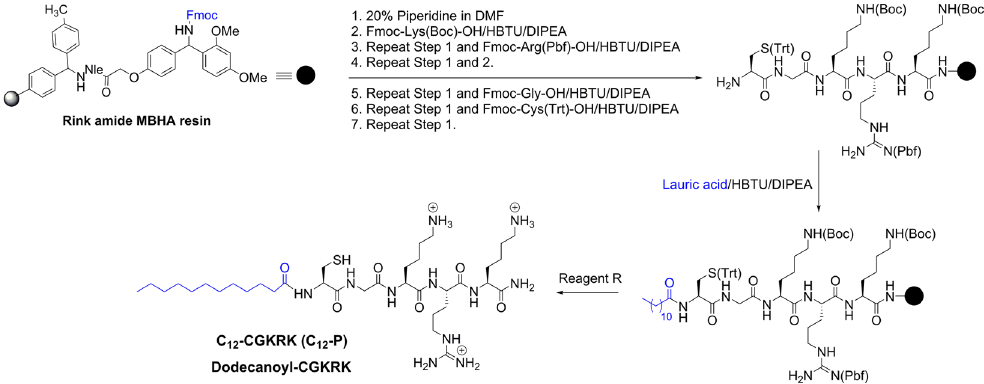
Figure 2. Synthesis of Dodecanoyl-CGKRK as a Representative